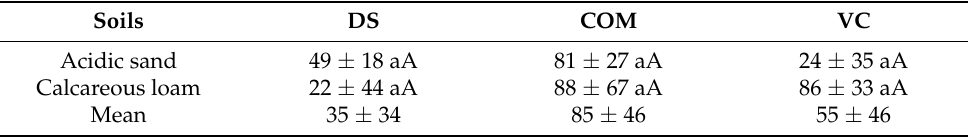
Table 3. Residual carbon content (RC, percentage of added organic carbon remaining in the soil, Equation (1)) for digested sludge (DS), digested sludge compost (COM), and digested sludge vermi- compost (VC) on the two soils (%). Data are the mean ± SD of the 3 replicates. Uppercase letters